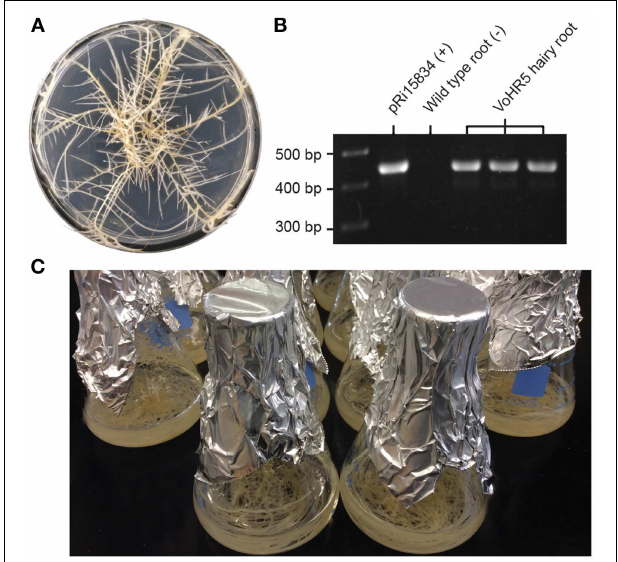
FIGURE 2 | Establishment and growth of V. officinalis hairy roots transformed with A. rhizogenes harboring root-inducing plasmid pRi15384. (A) Growth characteristics of the hairy root clone VoHR5 on semi-solid media. This clone featured vigorous growth and significant lateral branching that is typical of the hairy root disease phenotype. (B) PCR characterization of V. officinalis hairy root line VoHR5 for stable integration of A. rhizogenes root-inducing plasmid DNA. VoHR5 genomic DNA was isolated from three independent subcultures and used as template for amplification of the rolB gene. Plasmid pRi15834 was used as a positive control. Genomic DNA isolated from wild type plant root was used as a negative control. (C) Mature cultures of the VoHR5 line grown in shake-flasks before harvesting at 28